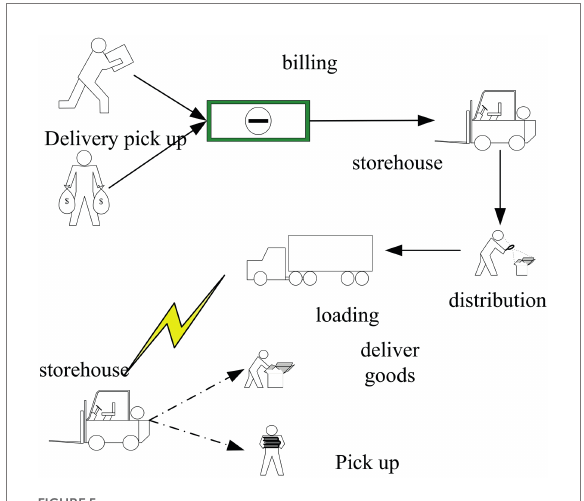
FIGURE 5 Overall job requirements for the entire express delivery